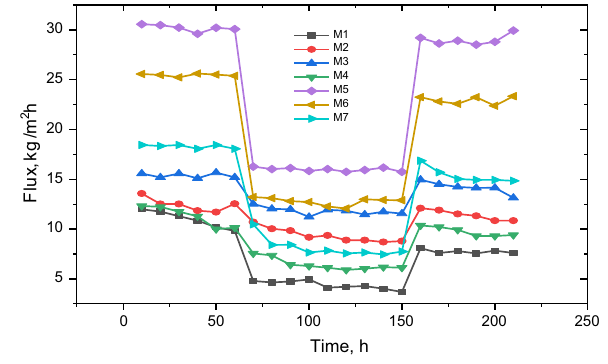
Fig. 6 Permeation flux versus time of the composite mixed matrix membranes